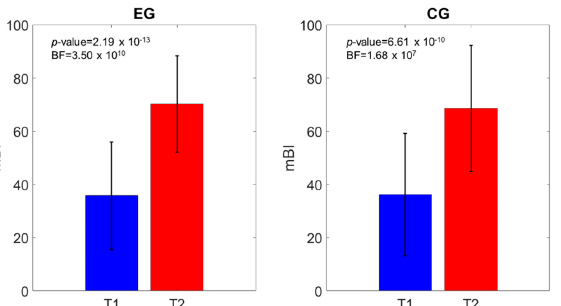
Figure 5. 10MWT velocity comparison of the scores at T1 and T2. The p -value and the BF of the intragroup effects are shown.